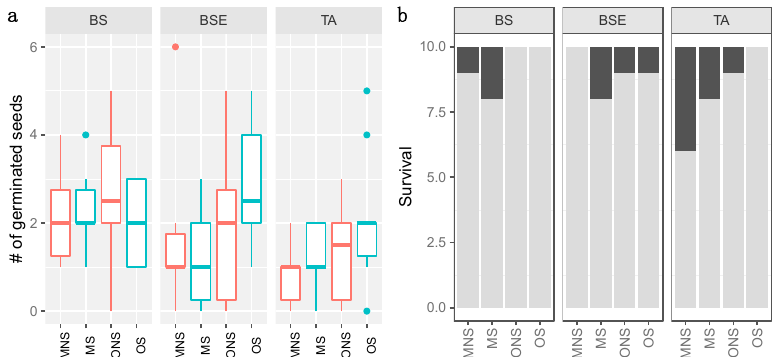
Figure 2. Number (#) of germinated seeds per pot and per treatment over 10 seeds ( a ) and Survival after three growth seasons ( b ). BS: Black spruce stand, BSE: BS with Ericaceae, TA: Trembling Aspen stand, M: Mineral, O: Organic, S, Sterile (blue), NS: non sterile (red). For the Survival ( b ), the proportion of dead seedlings is represented in black, while live seedlings at the end of the experiment are in grey.